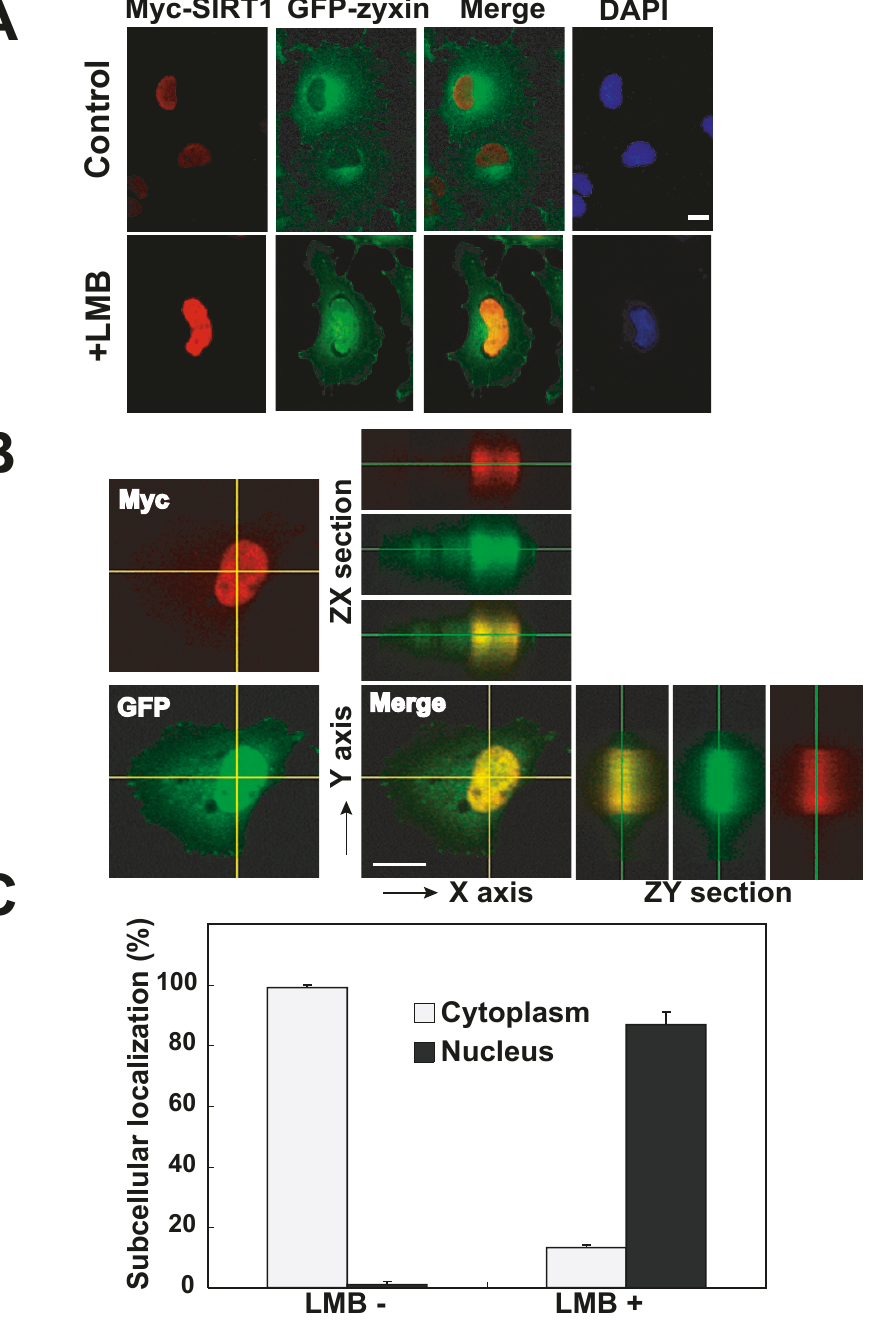
Figure 3 Leptomycin B treatment causes nuclear accumulation of zyxin and results in co-localization of SIRT1 with zyxin . (A) COS-7 cells transfected with plasmids encoding HA-SIRT1 and GFP-zyxin were cultured for 24 h, in the presence or absence of 20 nM Leptomycin B during the last 6 h. Cells were stained with anti-Myc. Bars, 20 μ m. (B) Confocal images show colocalization of SIRT1 and zyxin in nucleus in the presense of LMB. Bar, 10 μ m. (C) Zyxin localization was classified in COS-7 cells expressing HA-SIRT1 and GFP-zyxin. "Cytoplasm" indicates COS-7 cell exhibiting GFP-zyxin only in the cytosol. "Nucleus" indicates COS-7 cell exhibiting nuclear-accumulated GFP-zyxin. Results (%) are the mean ± SD from three independ- ent